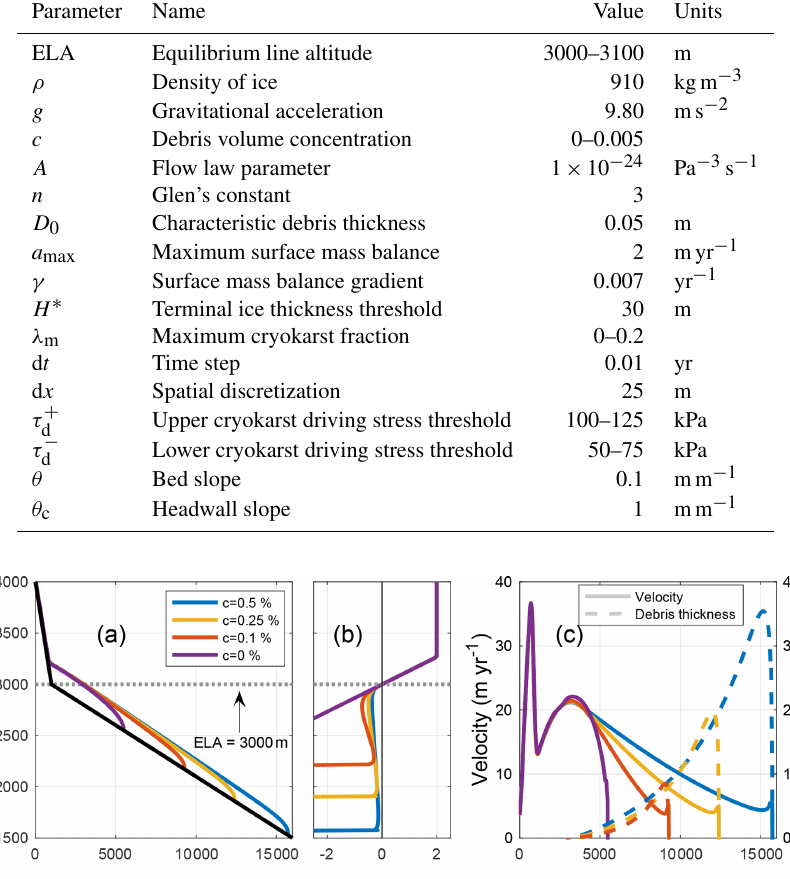
Table 2. Values used for the model parameters.